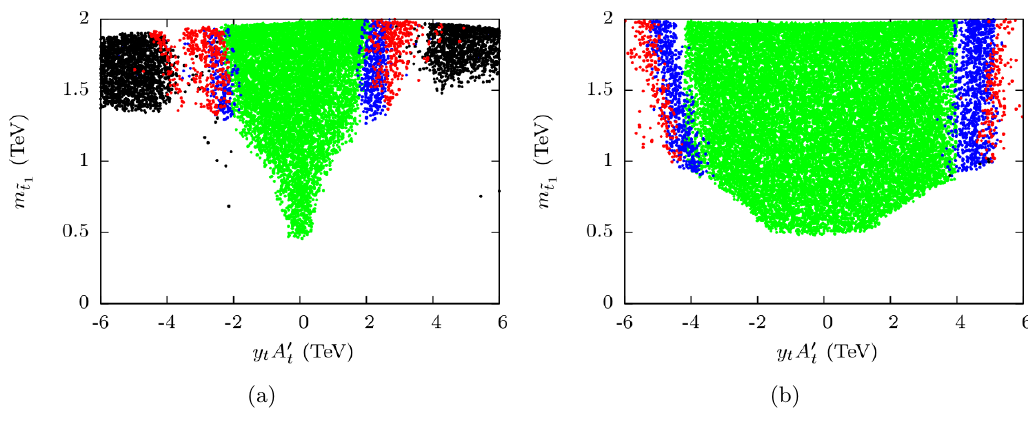
Figure 5 . The stability pro(cid:12)le of the DSB minima in y t A 0 scan of eq. (3.3). Figures 5(a) and 5(b) correspond to (5 < tan (cid:12) < 10) and (40 < tan (cid:12) < 50) respectively.The color codes are same as that for (cid:12)gure